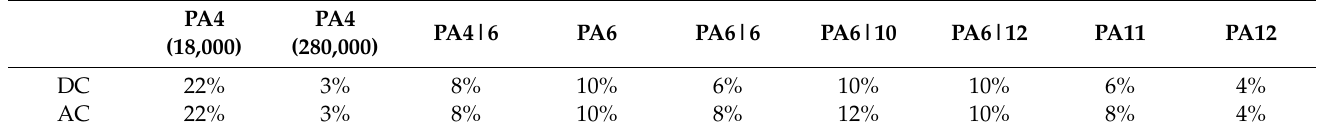
Table 1. Results of the macroscopic observation of the spinning processes of the PA solutions showing the most suitable concentrations of the solutions used in both the DC and AC systems. PA4 (18,000)